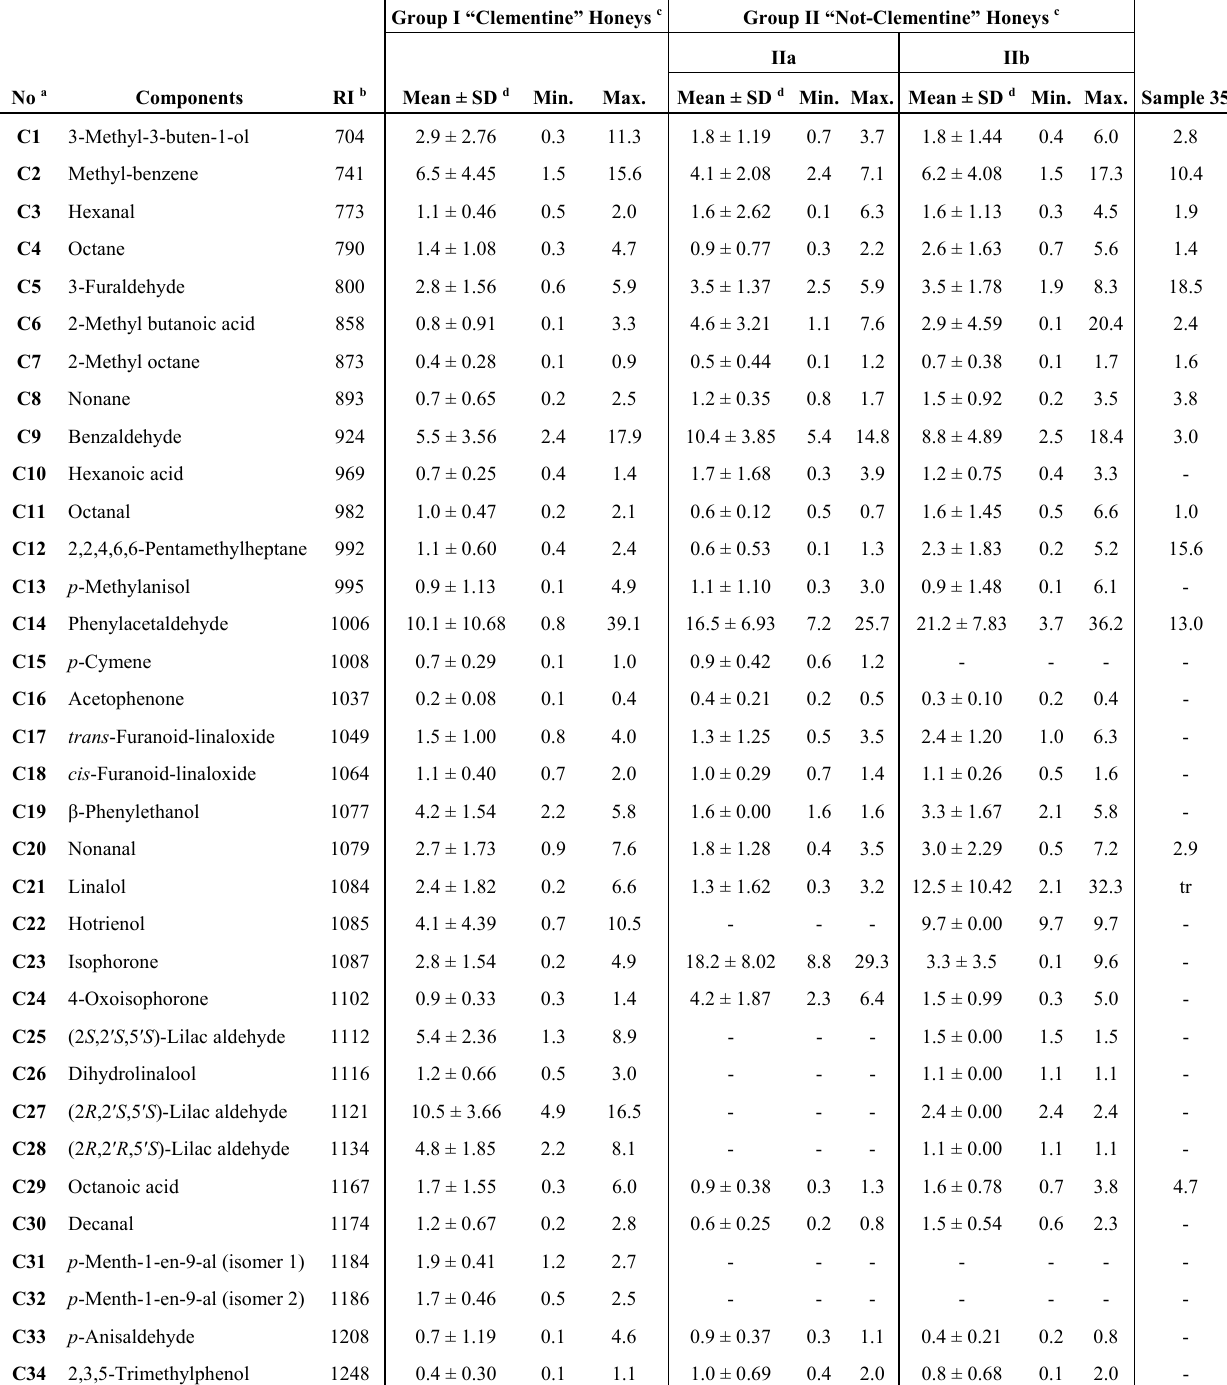
Table 3. Chemical composition of volatile fraction of Corsican “spring”